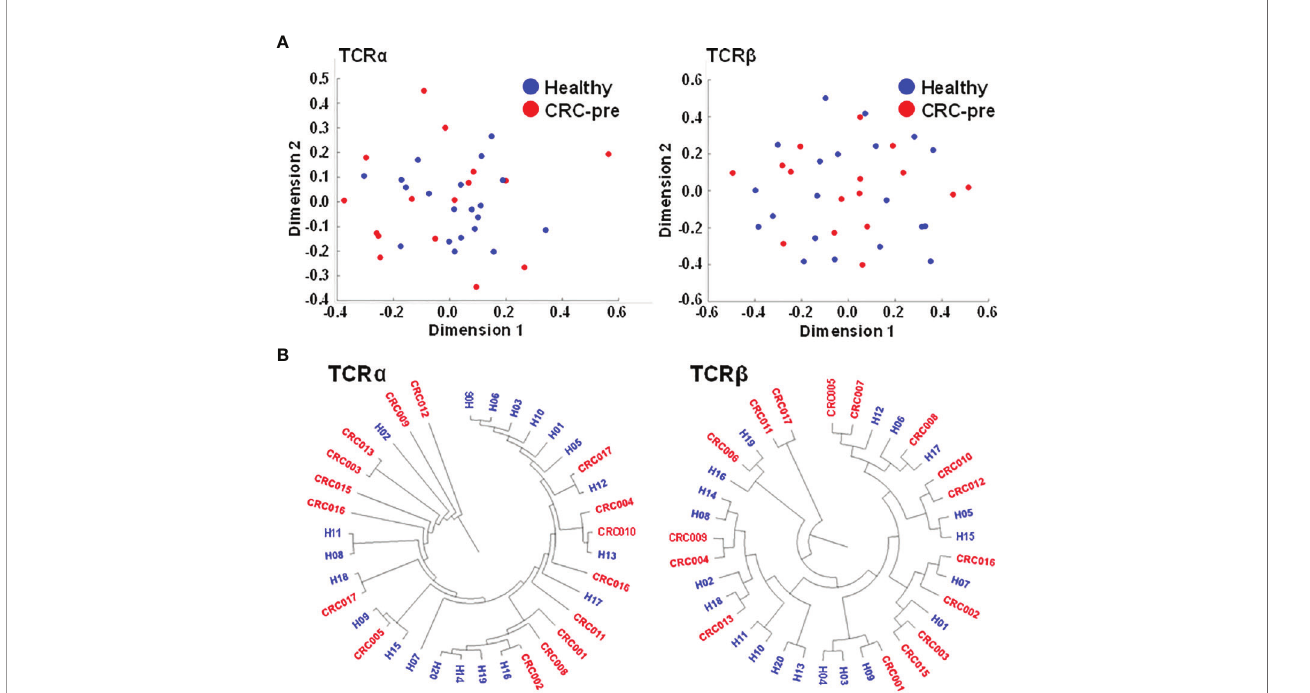
FIGURE 2 | Multidimensional scaling and phylogenetic analyses showing the similarities in CDR3 clonotypes of TCR repertoires. (A) TCR a and TCR b CDR3 clonotypes of healthy controls (n = 20; blue circles) and CRC-pre samples (n = 16; red circles) were subjected to multidimensional scaling to analyze the similarities in CDR3 sequences across samples. (B) Sample-based diversity matrices of CDR3 clonotypes in healthy controls and CRC-pre samples were analyzed using VDJtools to illustrate the distances between samples. The results are represented as a hierarchical phylogenetic tree.